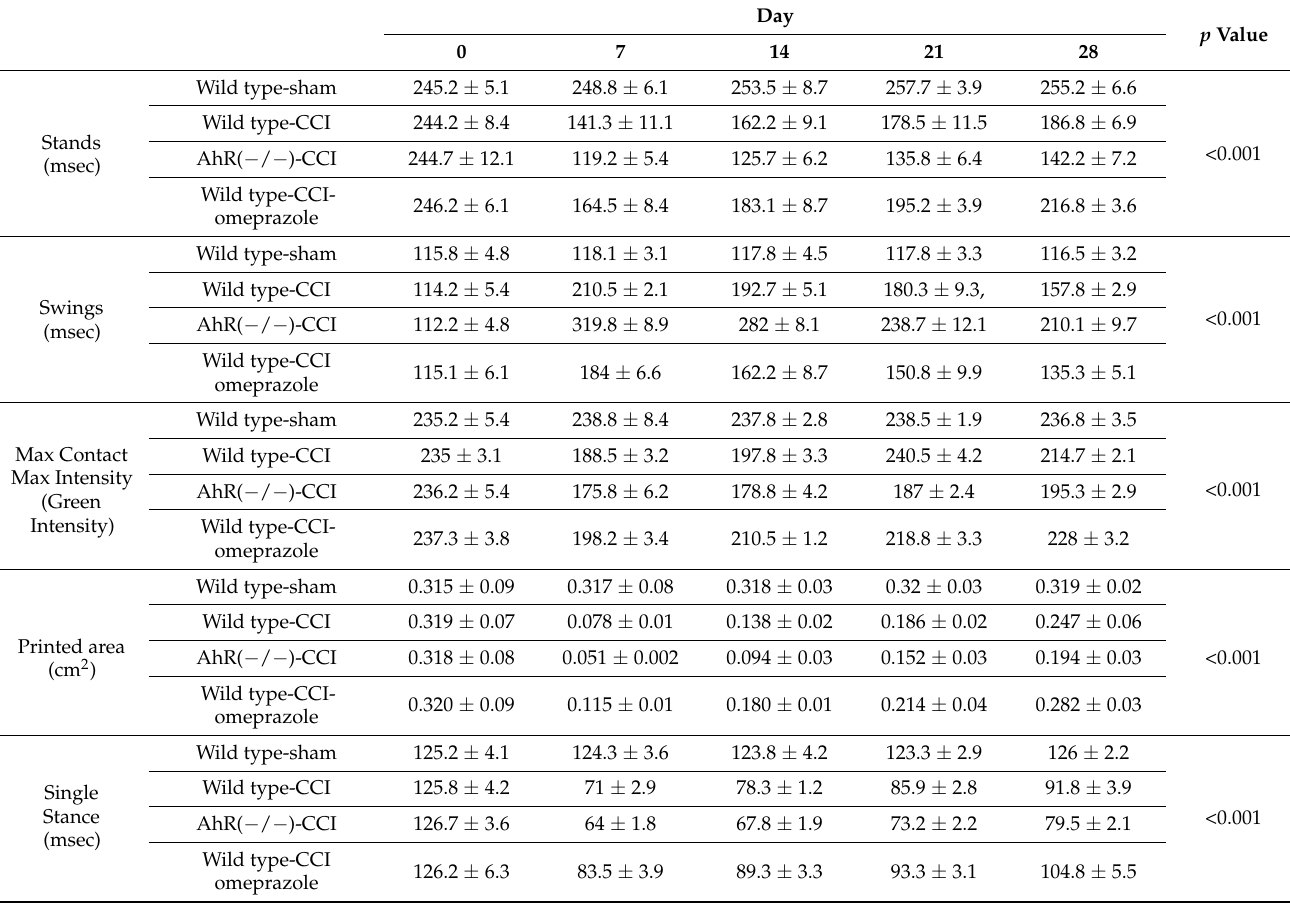
Table 1. Outcomes of various Catwalk gait analysis parameters at different time points in the various treatment